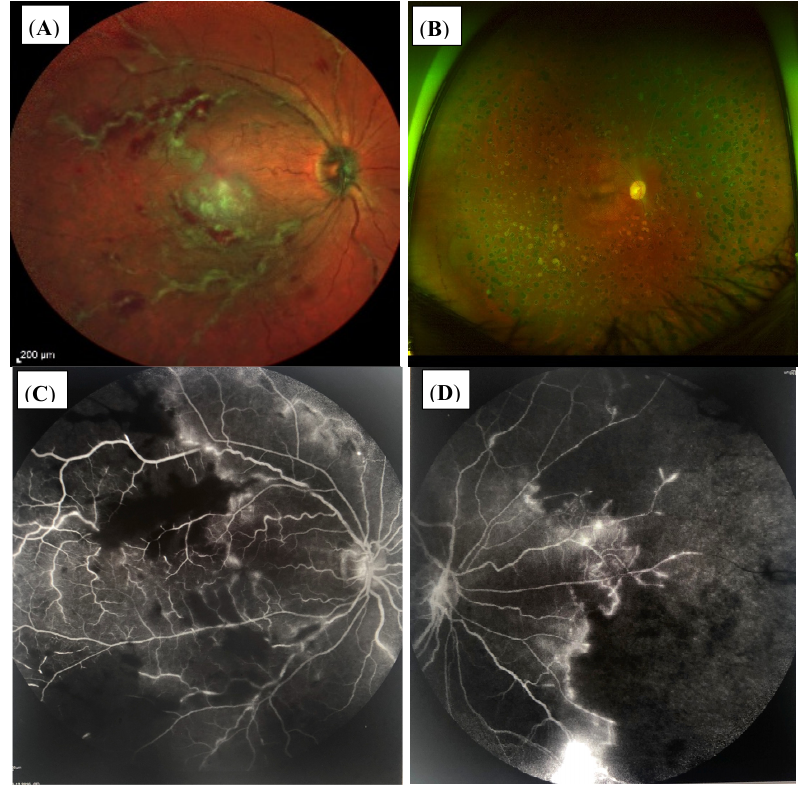
Figure 8. ( A – D ). Fundus OD of patient no. 13. ( A ) Active occlusive retinal vasculitis before initiating anti-inflammatory therapy. ( B ) Demonstrates the fundus appearance at month 24 after intravitreal